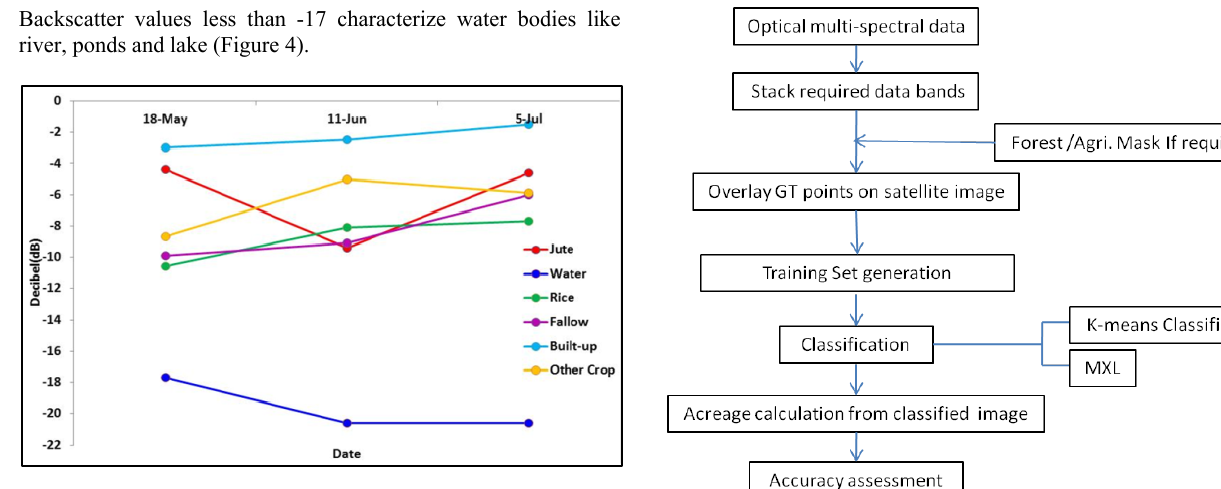
Figure 4: Temporal spectral profile of Different land cover of West Bengal